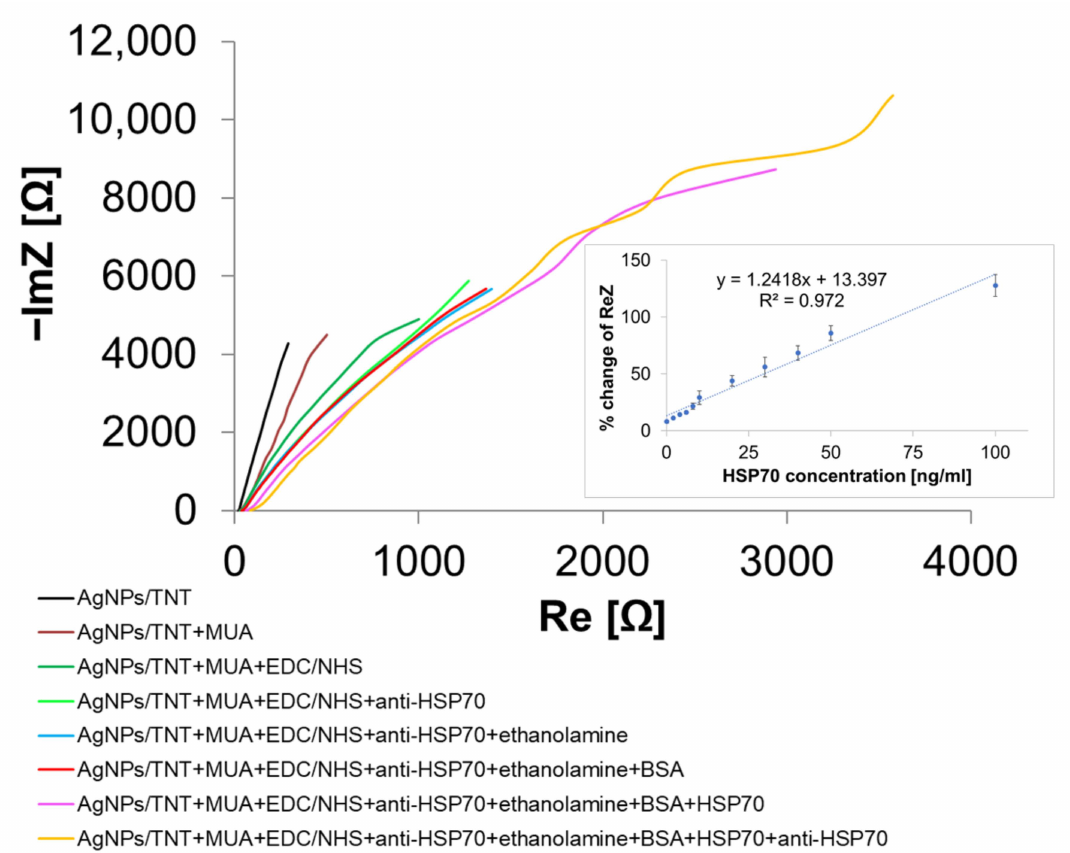
Figure 7. Nyquist plot showing immobilization steps (inset: HSP70 calibration curve obtained by the AgNPs/TNTs